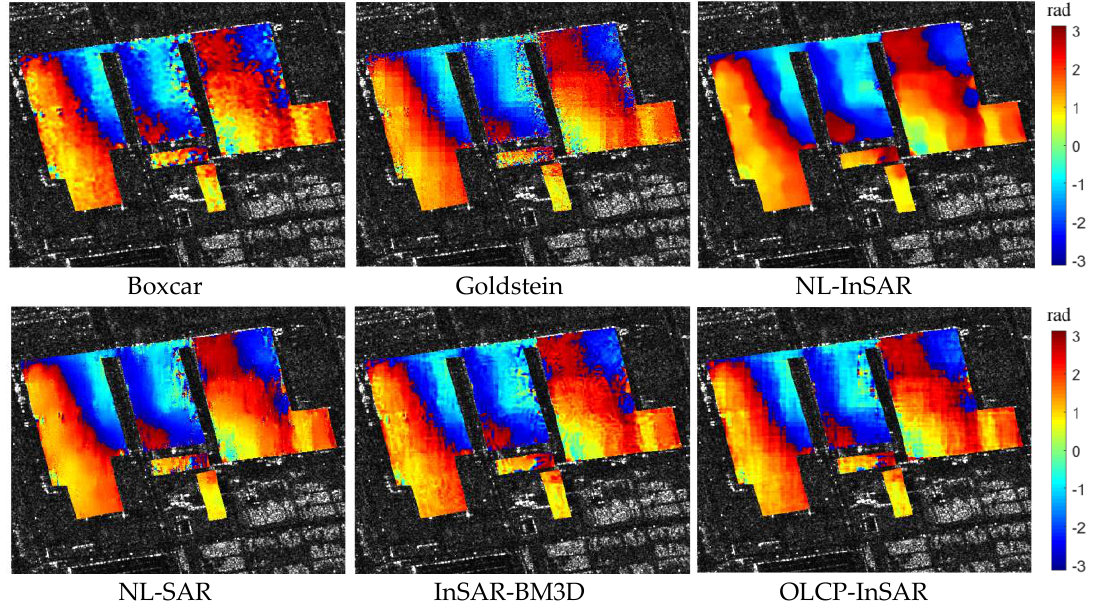
Figure 18. The filtered result of the first slice in the real InSAR tensor acquired by the filter operating on the matrix model.